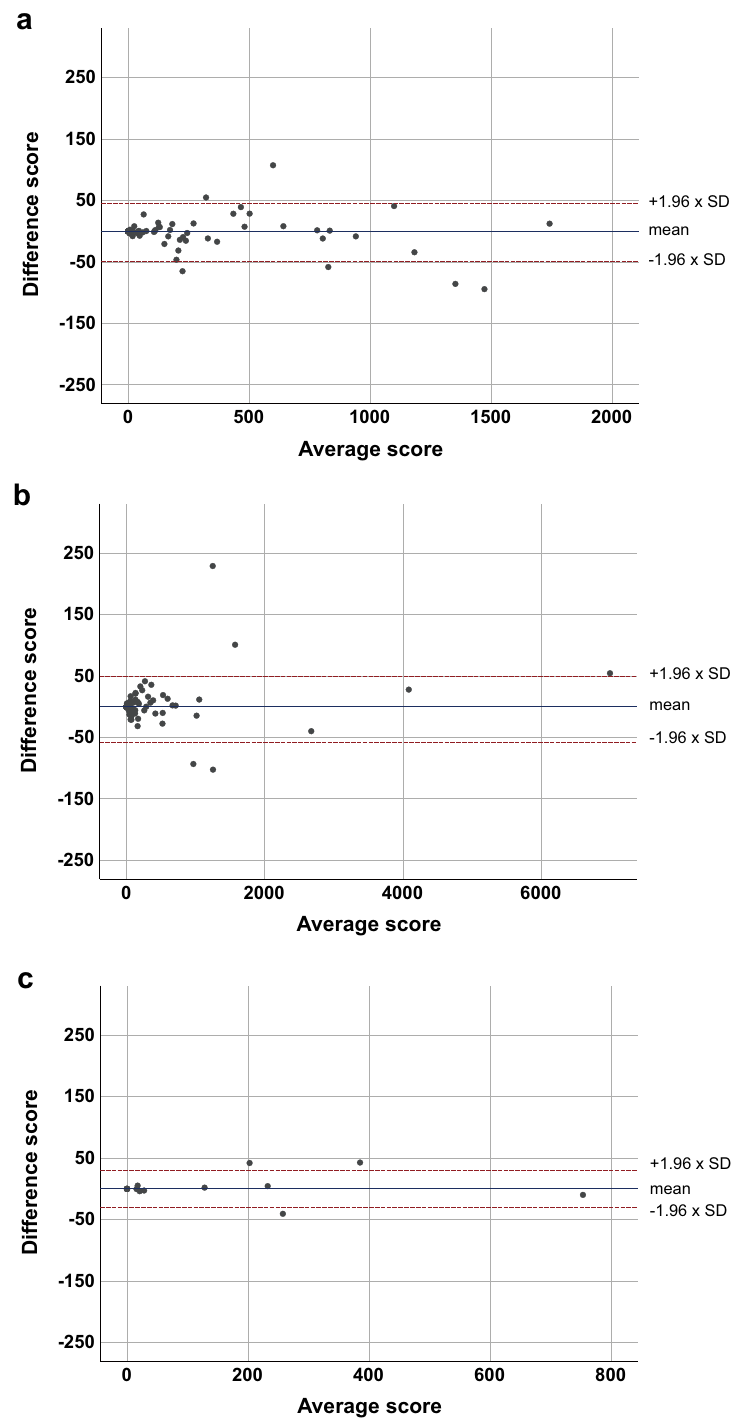
Figure 4. Bland–Altman plot between the standard and modified CAC scores from sub-analysis according to BMI. ( a ) BMI < 25 kg/m 2 , ( b ) 25 ≤ BMI < 30 kg/m 2 , and ( c ) BMI ≥ 30 kg/m 2